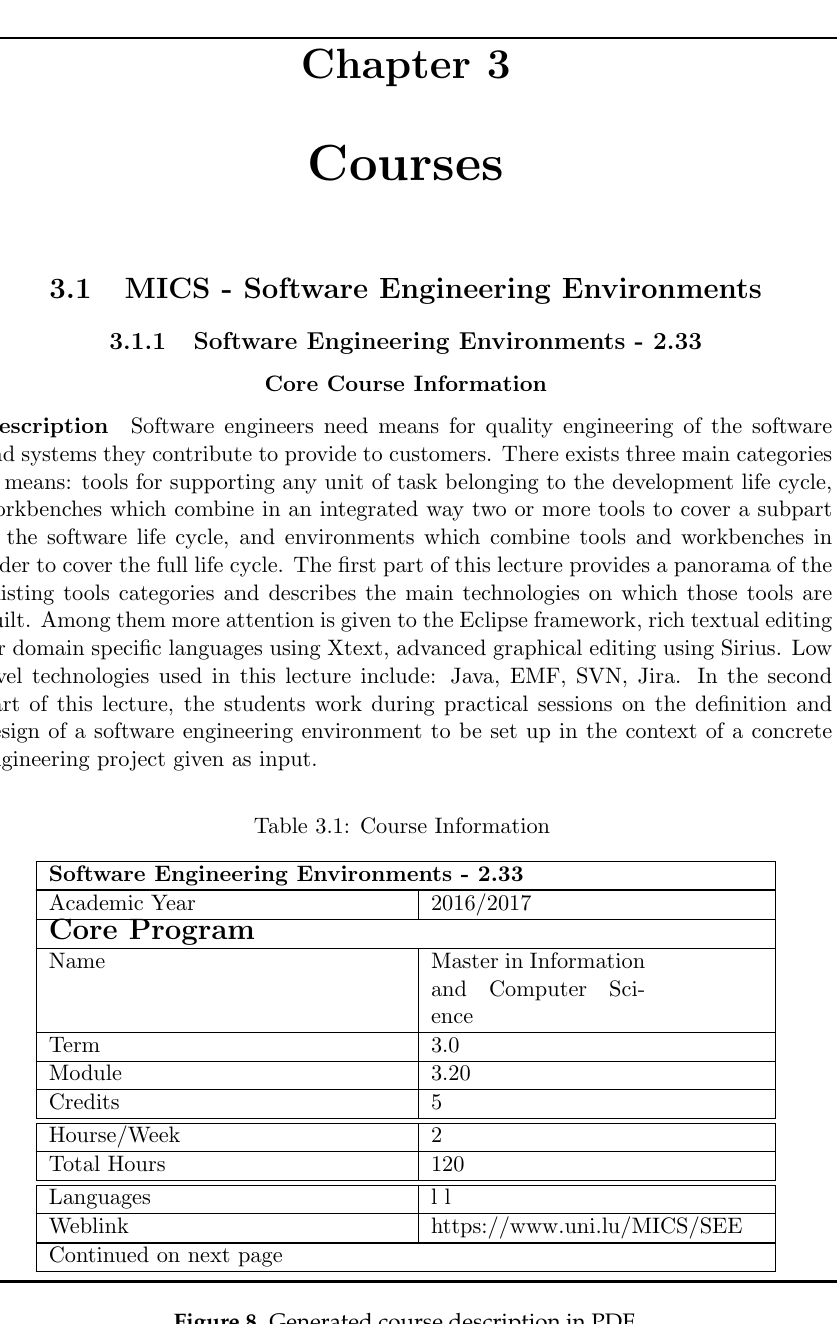
10 Figure 8. Generated course description in